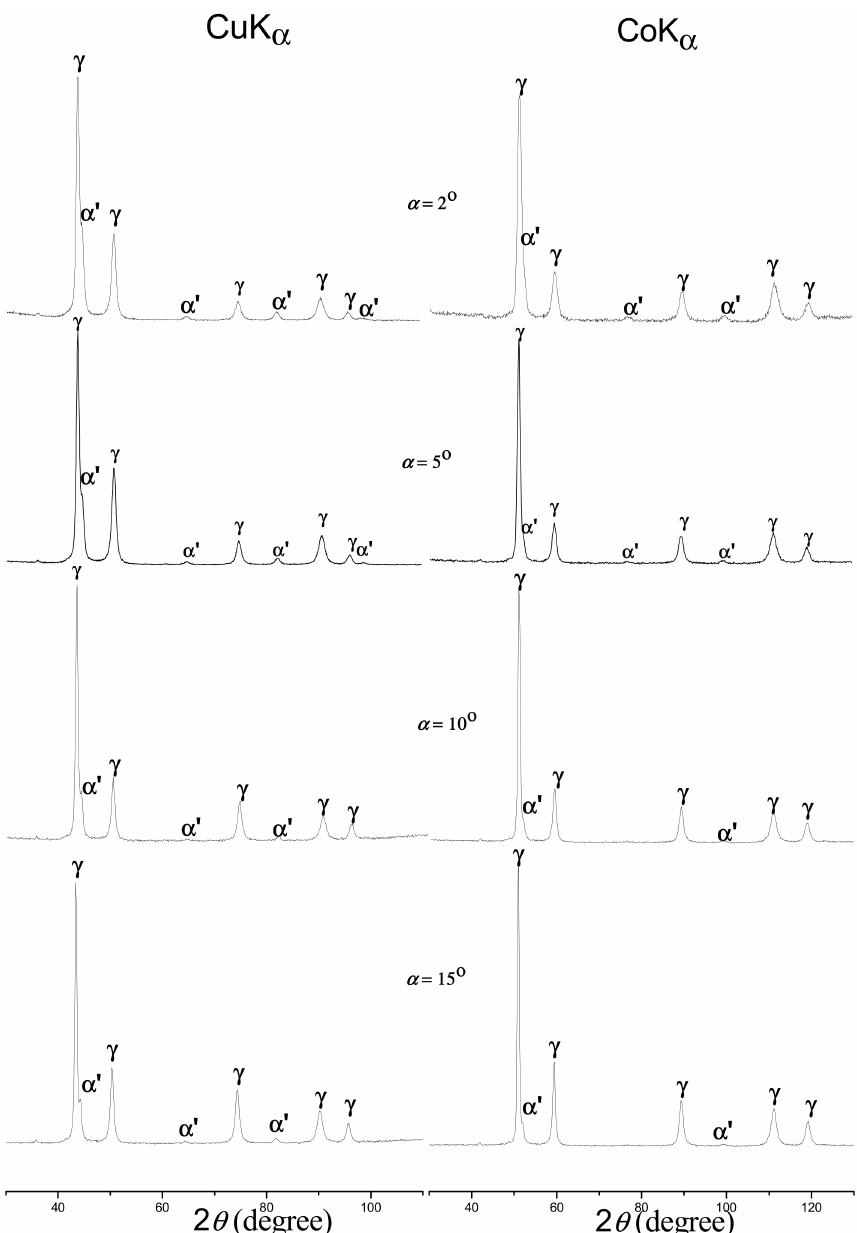
Figure 6. XRD patterns of initial AISI 321 steel obtained using CuK α and CoK α at various beam incident angles α